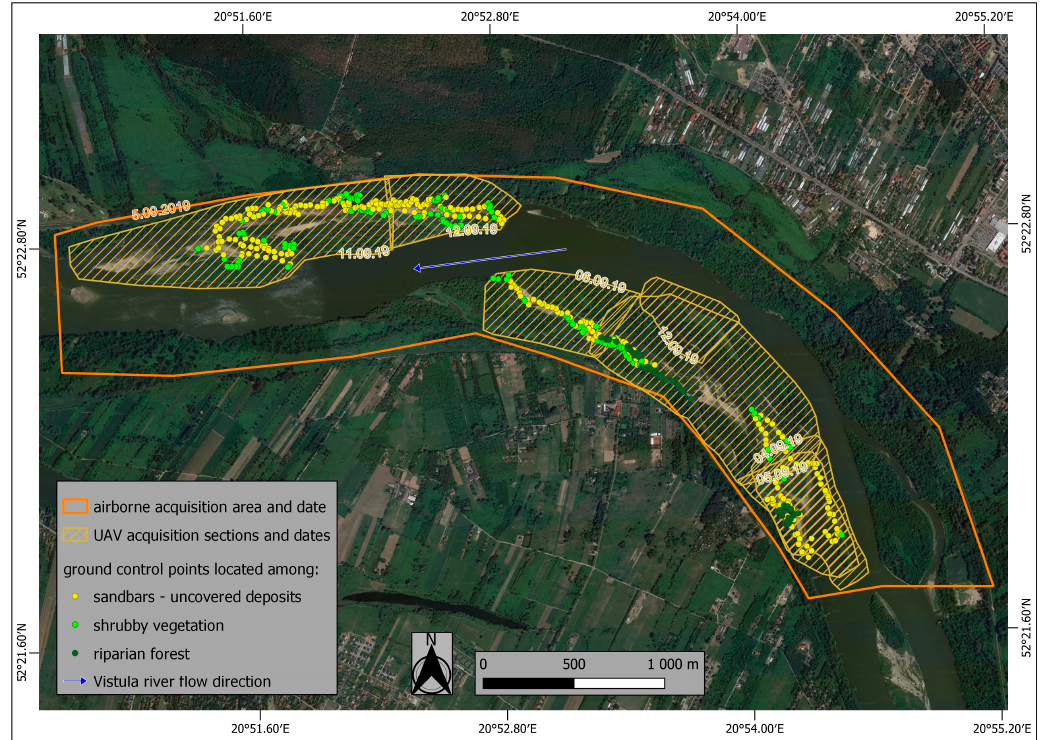
Figure 3. Study area. Islands within the “ Ł awice Kie ł pi ń skie” (“Kielpinskie Shoals”) natural reserve. Overlayed are acquisition sections of the airborne and UAV missions, and the distribution of ground control points from GNSS-RTK measurements. Background orthophotomap: Google Satellite. The characteristics of the fl ight carried out with the UAV (model DJI M600) were as follows: fl ight height up to 75 m above ground level, fl ight speed 5.5 m/s, distance between paths 45 m, fl ight time up to 17 min, and 2-4 fl ights per day.